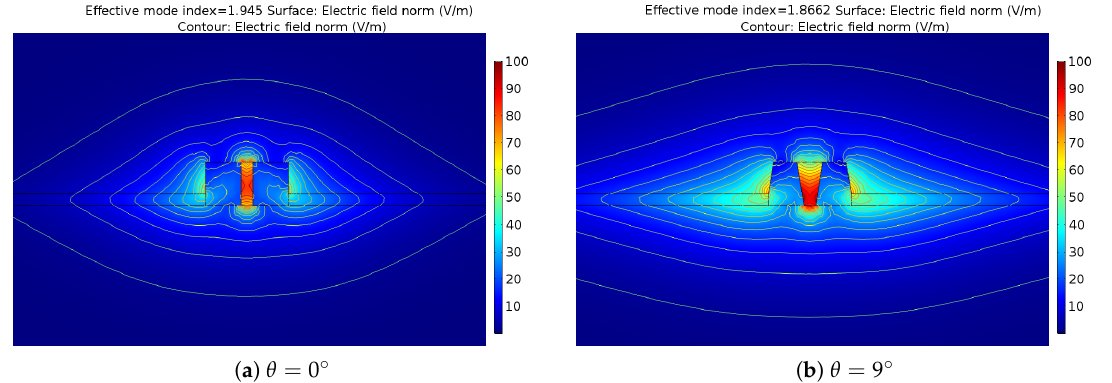
Figure 5. Influence of sidewall tilt angle θ on the modal properties. It becomes visible that confinement of the optical mode decreases with larger angle.